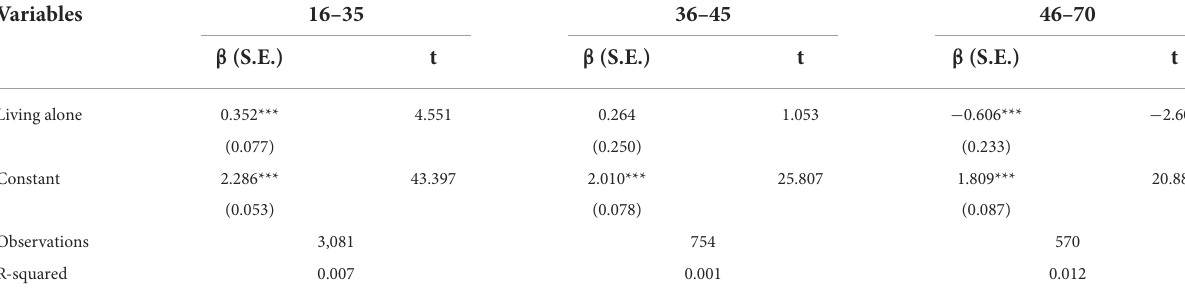
TABLE 4 Effect of the live alone on mental health, by age.